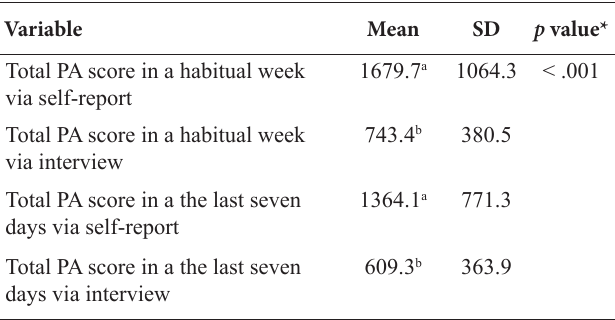
Table 2. Mean and standard deviation of the total PA scores (minutes/ week) measured using the long version of IPAQ, in a habitual week and in the last seven days, obtained via self-report and via trained interviewer ( n =38).